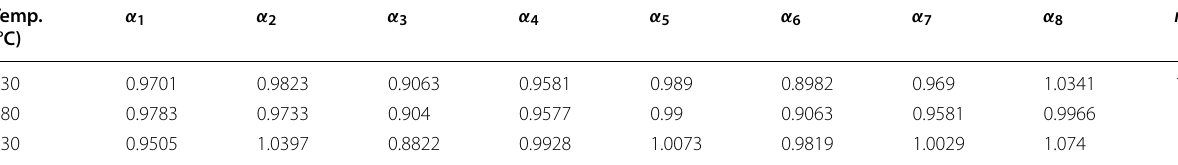
Table 7 Identified parameters of Yld2000-2d yield function with m = 14 ( ε p = 0.01 ) α 1 α Temp. (°C)